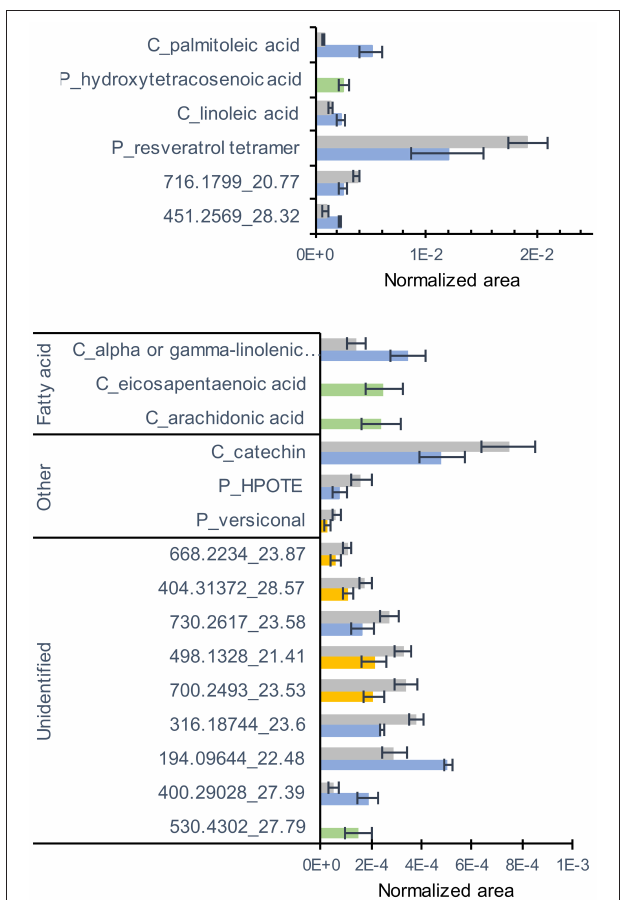
FIGURE 4 | LC-MS metabolites significantly altered by the mycorrhization in roots. Contents are expressed as normalized areas for each metabolite. Data are the mean ± SE of 14 independent biological replicates for the NM condition and 11 independent biological replicates for the Ri condition. Metabolites significantly different between NM and Ri conditions were identified with a fold change of at least + /– 1.5 and a p value < 0.05 (in blue) or a p value < 0.1 (in yellow, Wilcoxon test). Metabolites only present in the Ri condition are shown in